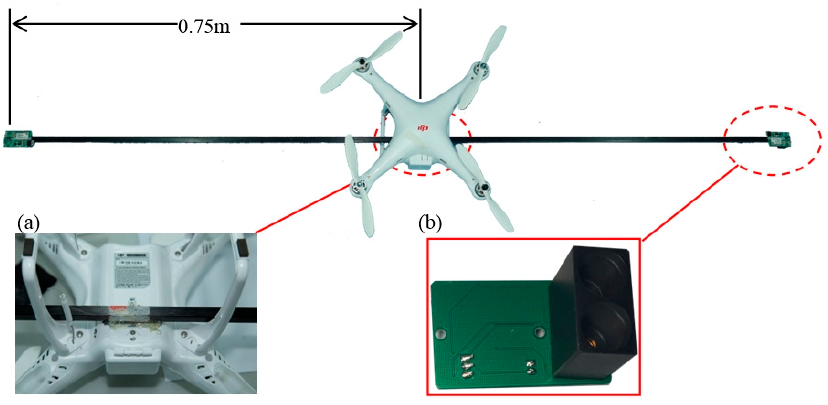
Figure 9. The UAV-borne crop-growth sensor. ( a ) Installation of sensor support; ( b ) Two-band sensor.